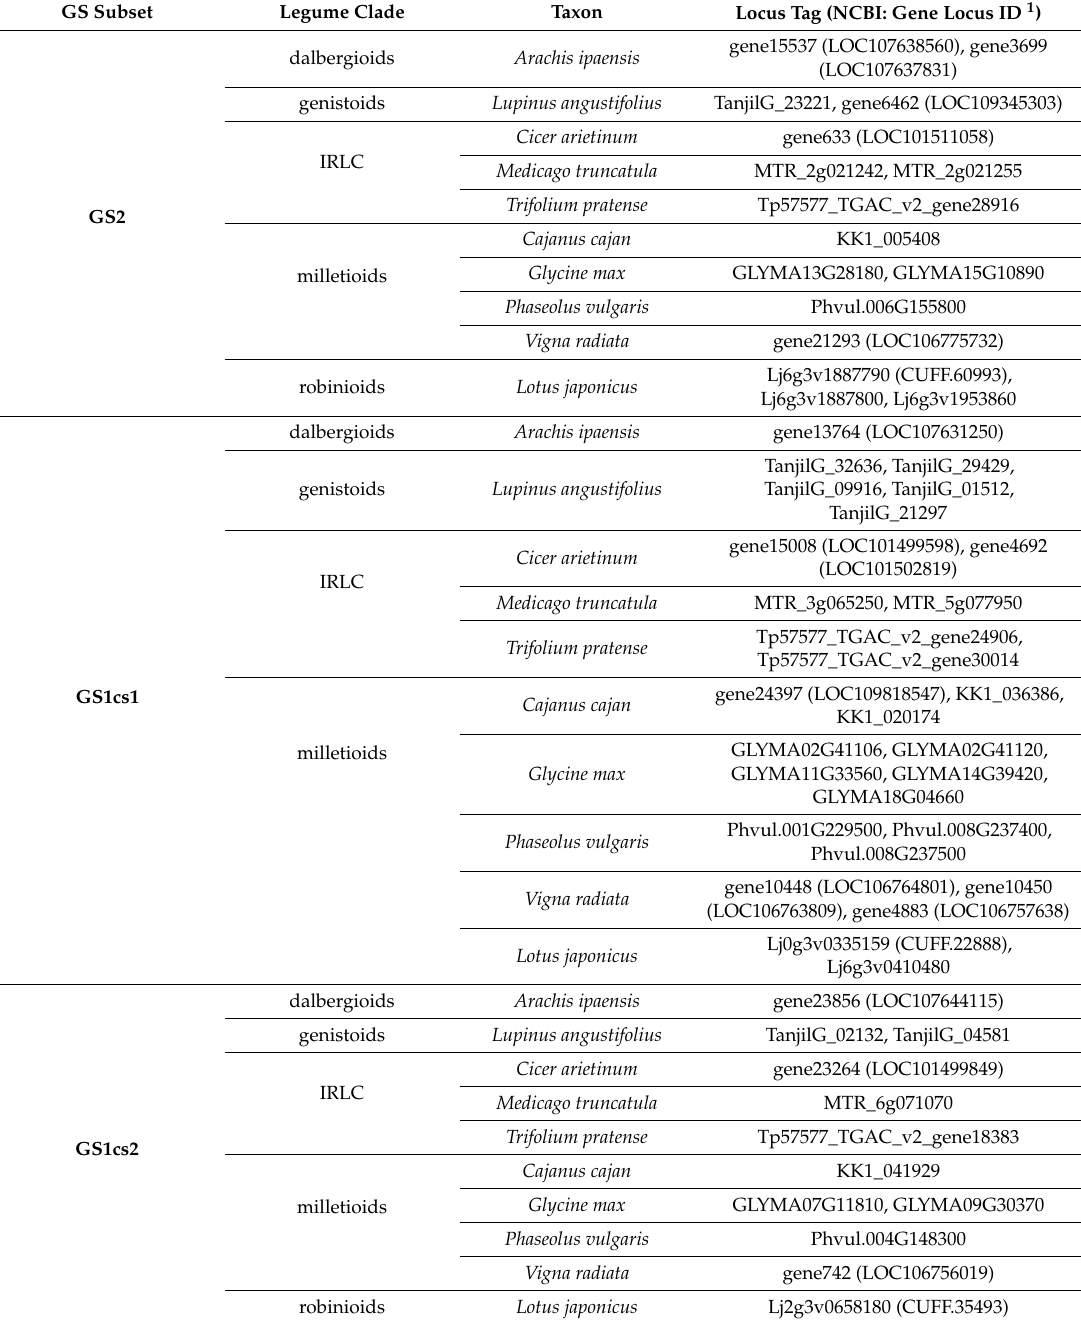
Table 2. Summary of major glutamine synthetase clades traced to the ancestral legume genome (monophyletic, support over